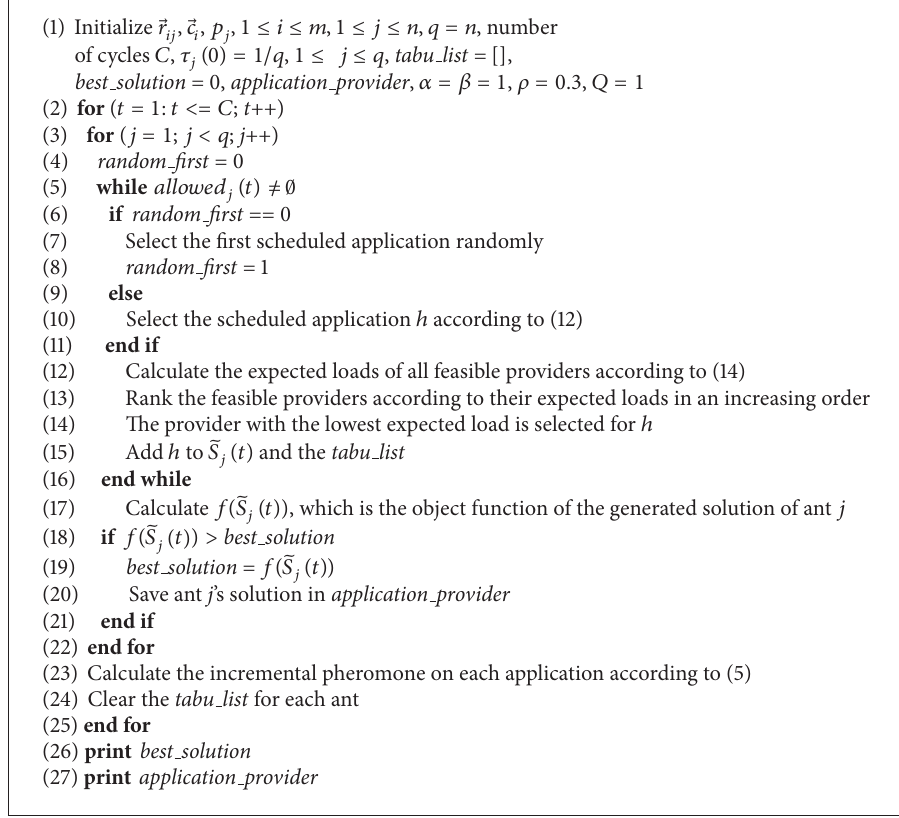
Algorithm 1: The HACAS